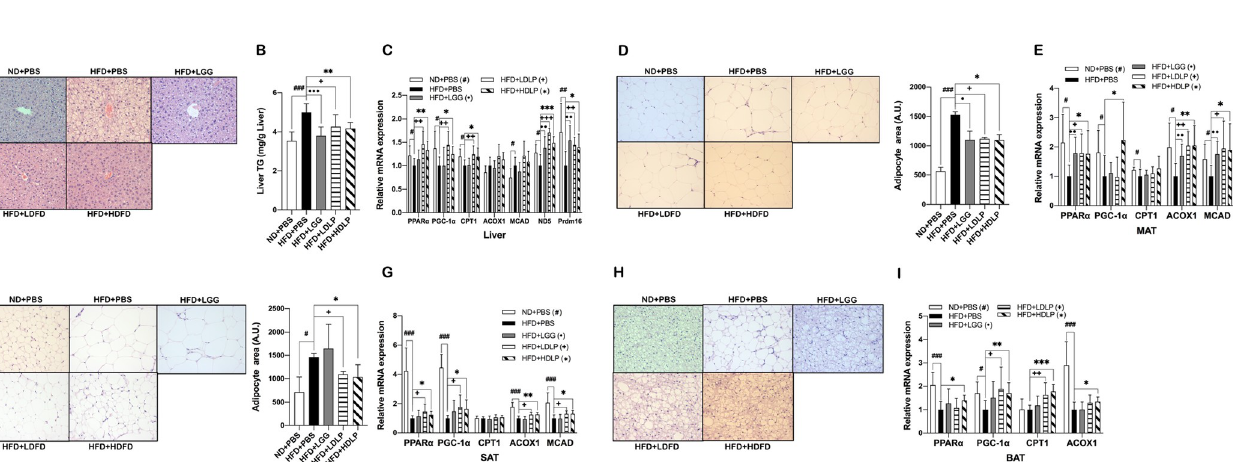
PLOS ONE | https://doi.org/10.1371/journal.pone.0228932 February 10,